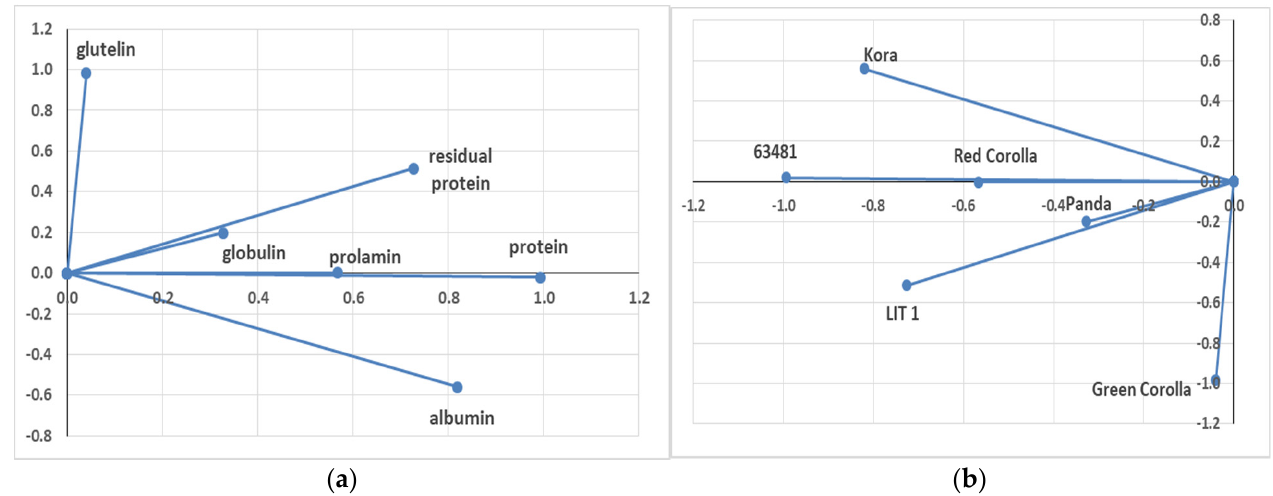
Figure 4. Principal component analysis (PCA) of protein content of F. esculentum and F. tataricum genotypes ( a ) and individual graph of the tested genotypes ( b ).